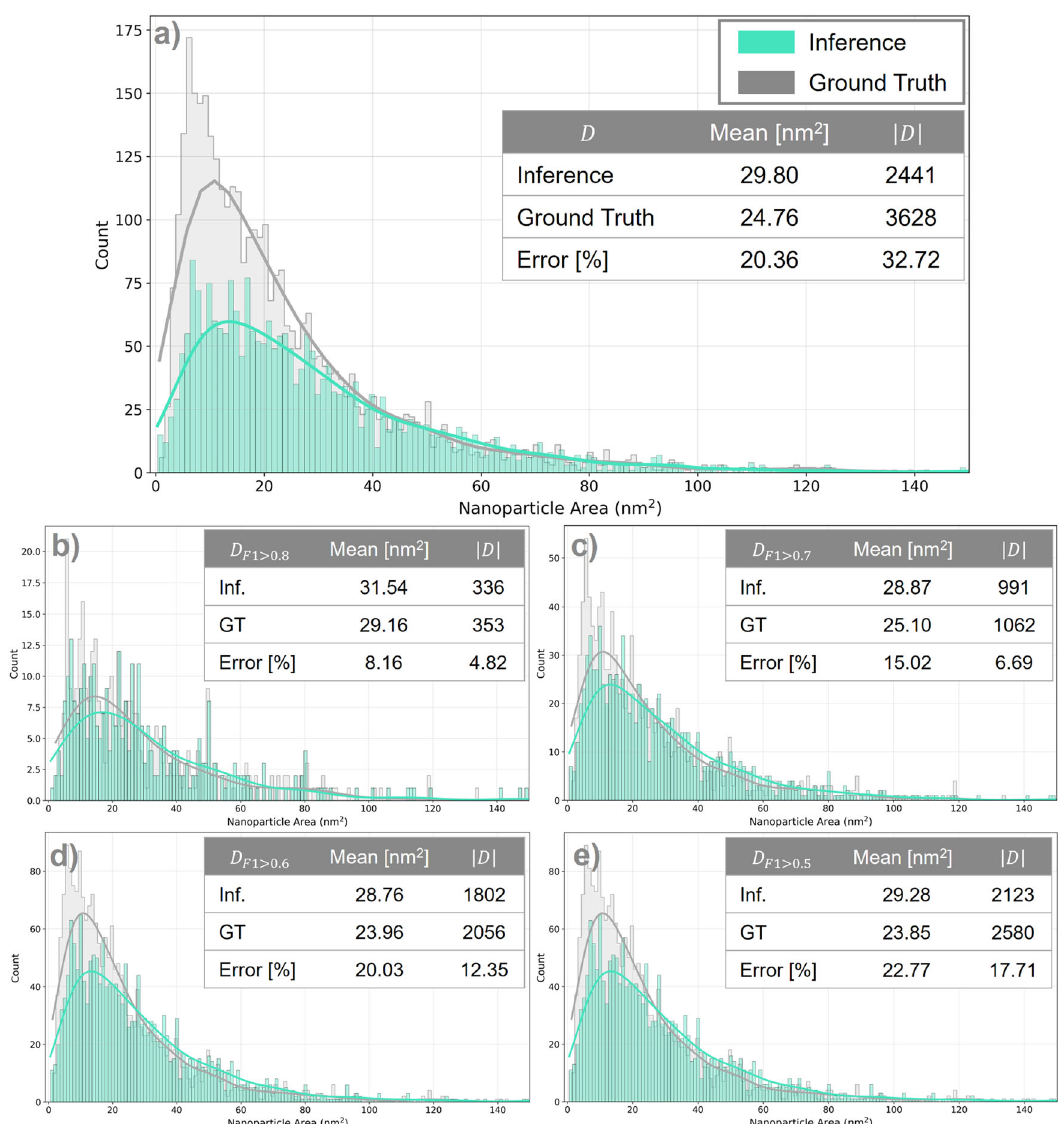
Fig. 6 Histograms (1 nm 2 ∙ bin -1 ) and KDE-plots of calculated nanoparticles areas (nm 2 ) for the ground truth and inferred datasets for the Pd/C system. KDE-plots were generated using a Gaussian Kernel and Scott ’ s rule 53 . Tables containing the calculated mean nanoparticle area (nm 2 ), nanoparticle counts in the dataset (| D |) and calculated errors with respect to the ground truth are shown. Plots were generated for a The full dataset, b Images with an F1-Score of >0.8, c Images with an F1-Score of >0.7, d Images with an F1-Score of >0.6 and e Images with an F1-Score of